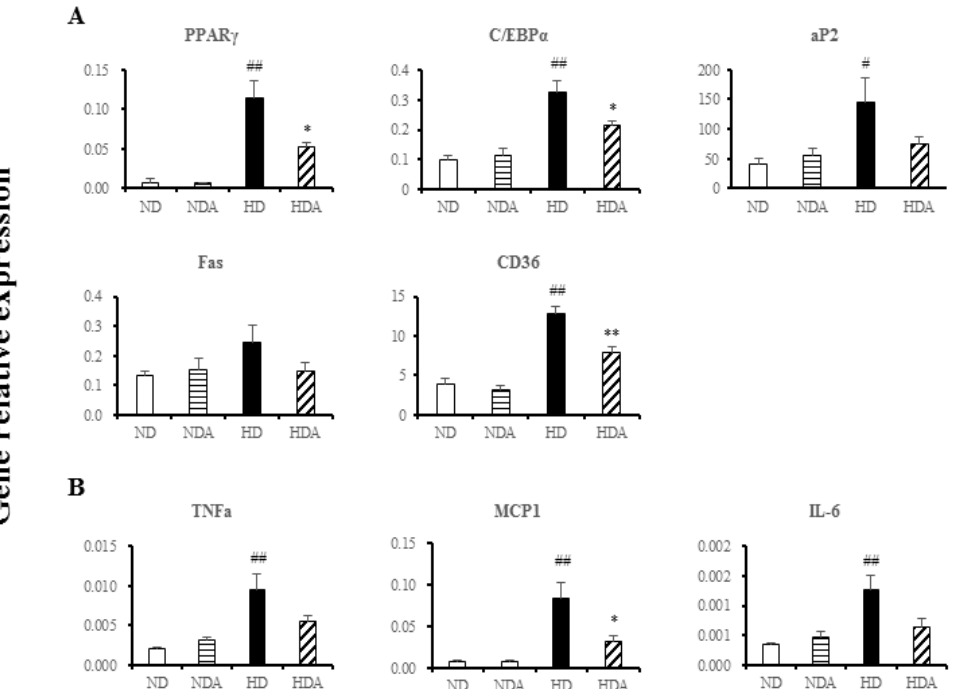
Figure 3. Effect of L. sakei ADM14 on gene expression in the epididymal fat pads. ( A ) The mRNA expression levels of PPARγ, C/EBPα, aP2, CD36, and FAS as measured by quantitative real-time polymerase chain reaction. ( B ) Effect on expression of anti-inflammatory genes measured by quantitative real-time polymerase chain reaction. PPARγ, peroxisome proliferator-activated receptor-γ; C/EBPα, CCAAT-enhancer-binding protein-α; aP2, adipocyte protein 2; CD36, cluster of differentiation 36; FAS, fatty acid synthase; TNFα, tumor necrosis factor alpha; MCP-1, monocyte chemotactic protein 1; IL-6, interleukin-6. Results are shown as mean ± SEM ( n = 5). Significant differences between HD and ND groups are indicated as # p < 0.05, ## p < 0.01. Significant differences between HD and HDA groups are indicated as * p < 0.05, ** p < 0.01.